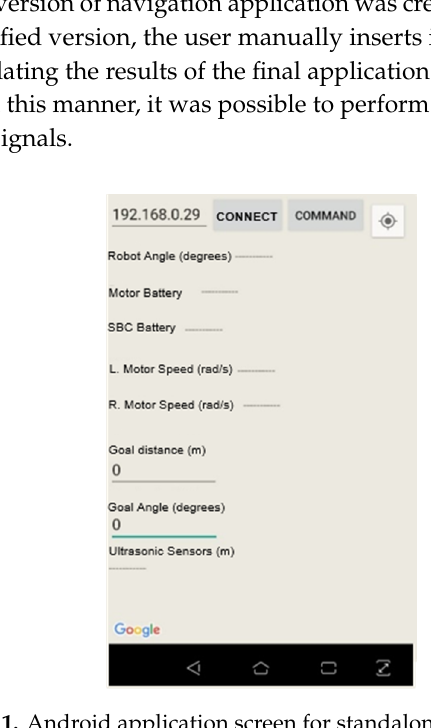
Figure 11. Android application screen for standalone navigation test.